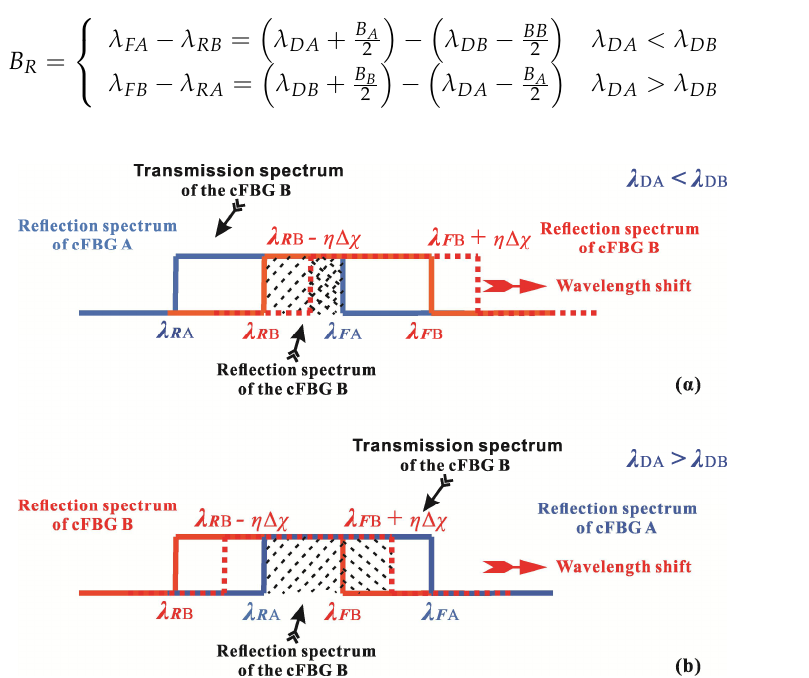
Figure 2. Relationships between the reflection spectra and transmission spectra of the sensor when the wavelength of cFBG B shifts in the long wave direction ( a ) for λ DA < λ DB , and ( b ) for λ DA < λ DB .